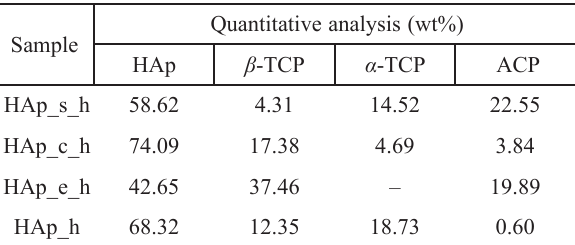
Table 3 – Quantitative analysis of phases in heat-treated CaP powders performed by Rietveld refinement